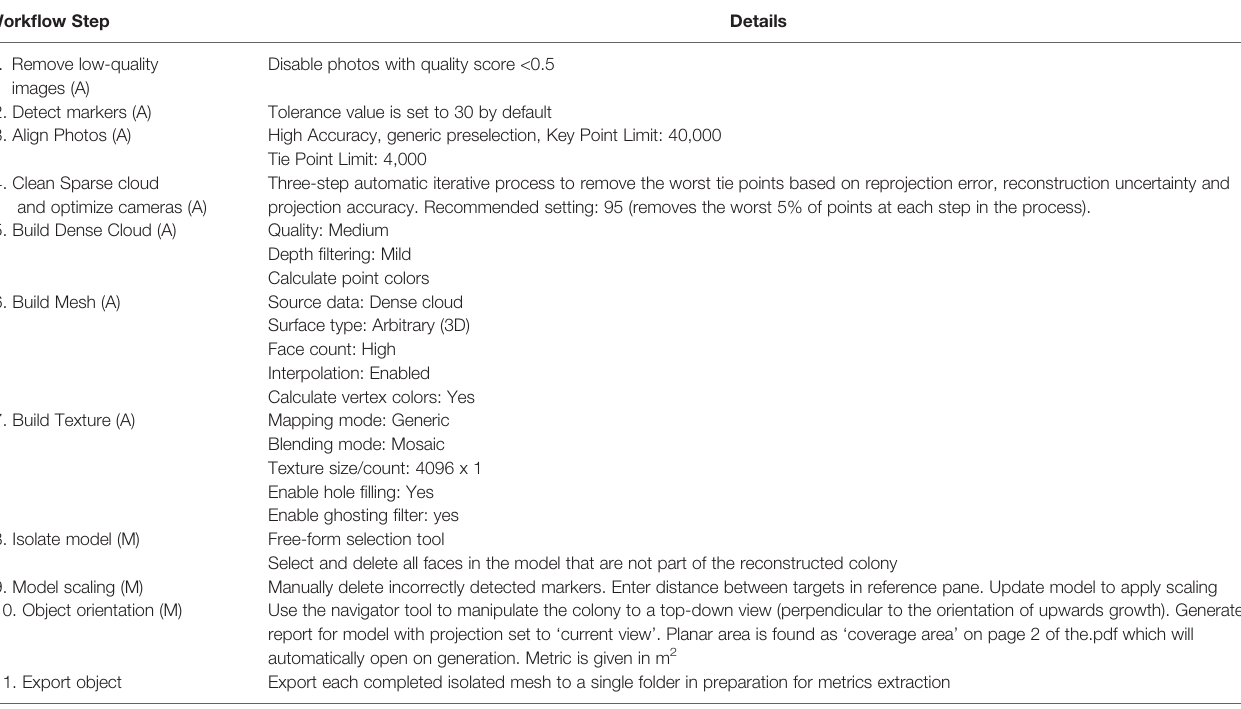
TABLE 1 | Beginning to end of reconstruction pipeline in